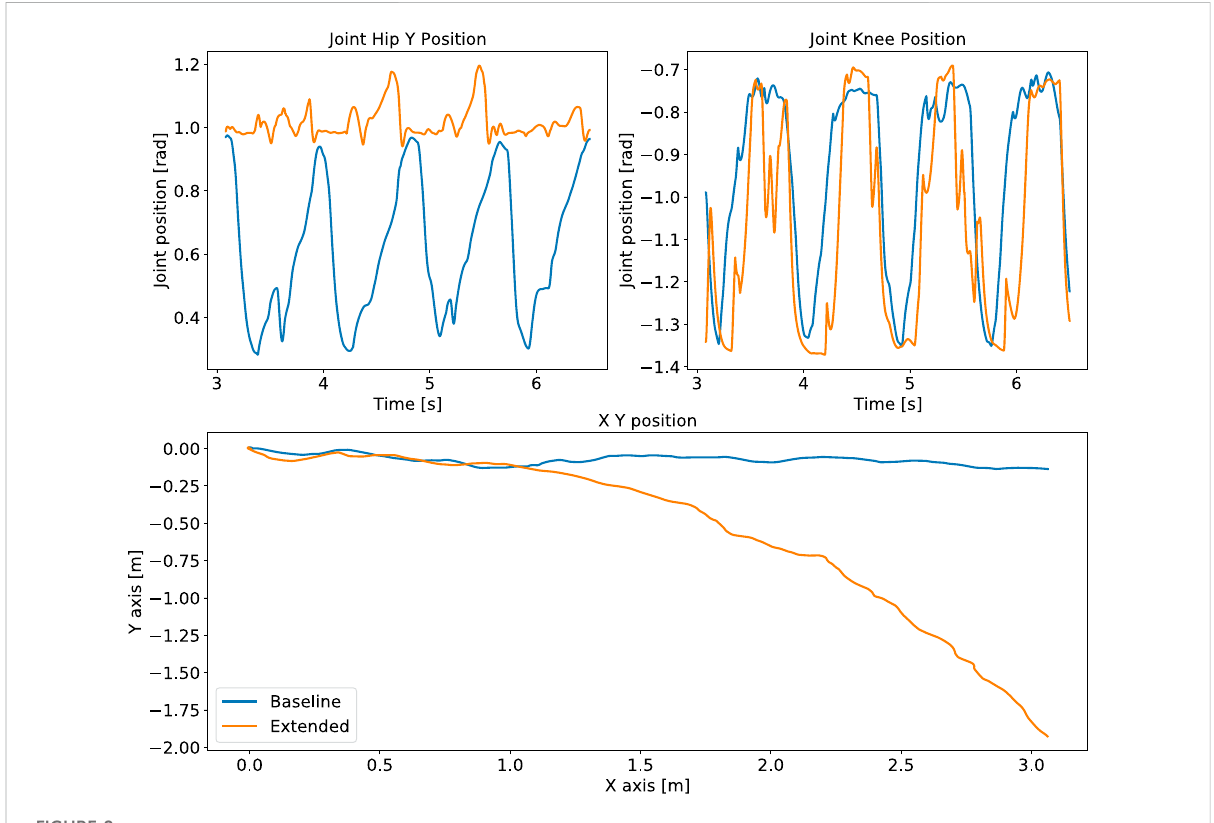
FIGURE 8 Locomotion performance: comparison of policies trained using the optimal baseline state space versus the extended states. Failure to capture periodicity (top) anddriftof robot position(bottom)fromtheextended state spacepolicy (orange),compared to ourformulatedbaseline policy with optimal state space